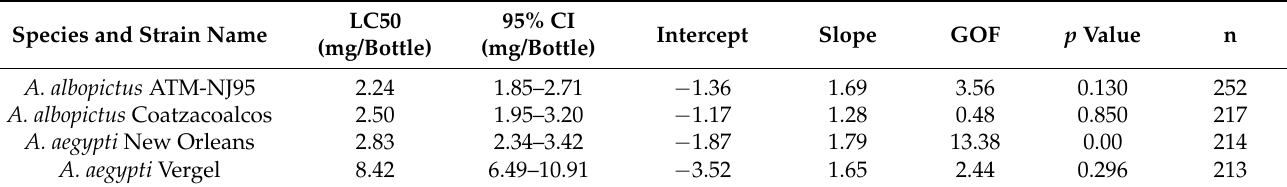
Table 2. Summary of nootkatone LC50 (cid:48) s and corresponding 95% confidence intervals (CIs) among Aedes strains. Concentration–response was adjusted to a binomial logistic regression model (intercept and slope). Pearson goodness of fit (GOF), p value, and sample sizes are provided. Degrees of freedom = 1.